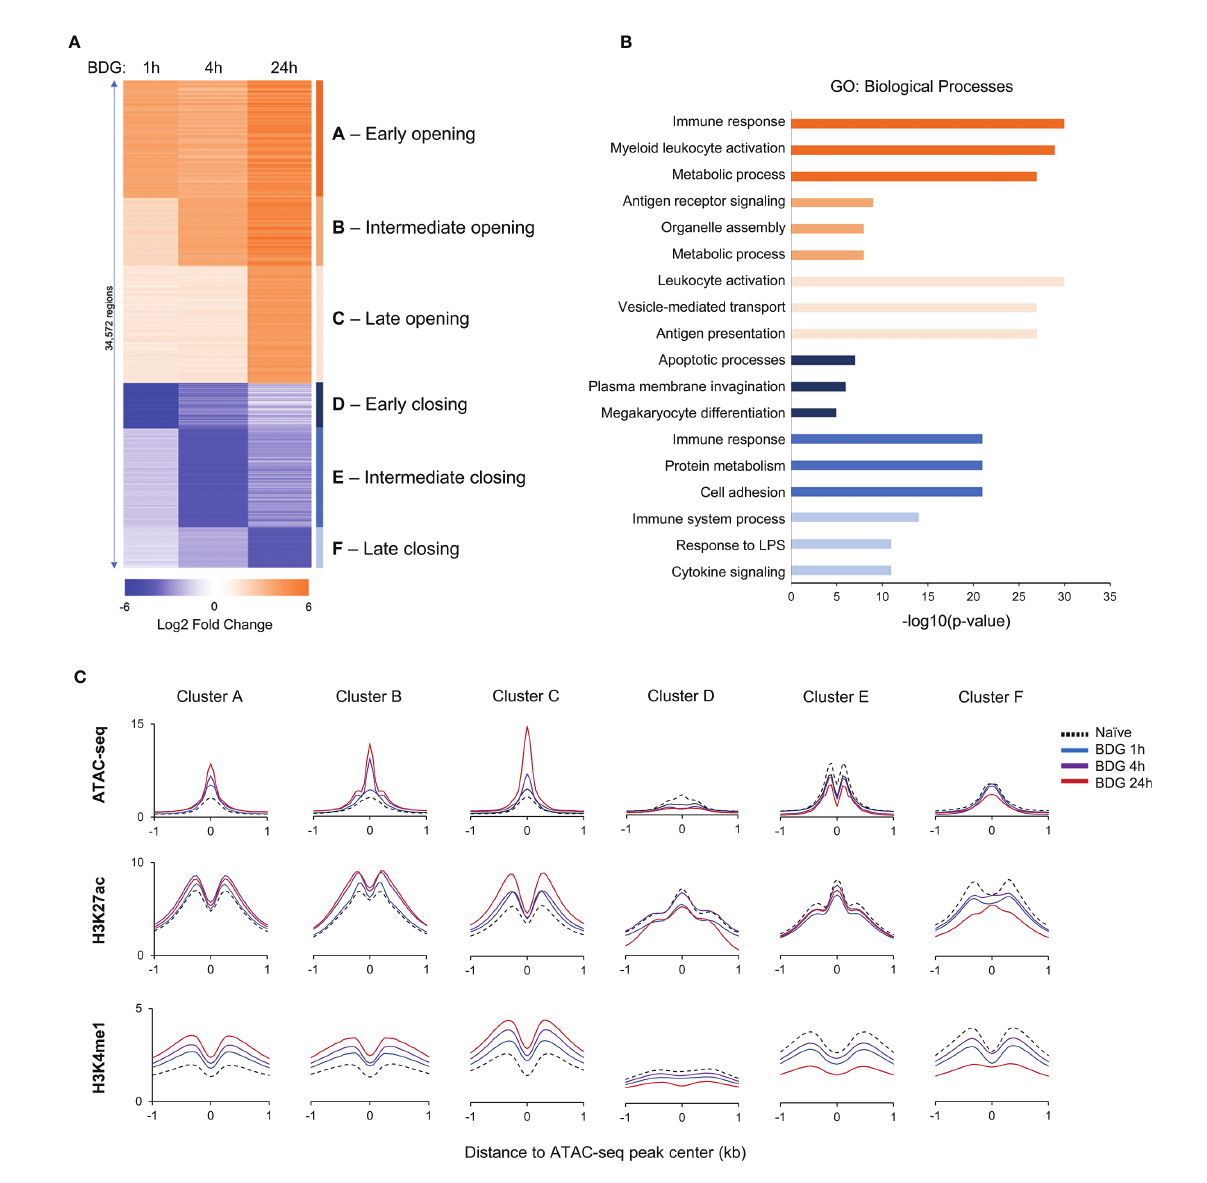
FIGURE 1 | Changes in the epigenetic landscape of monocytes after BDG exposure. (A) Heatmap of differentially accessible regions (DARs) after BDG exposure identi fi ed using ATAC-seq; fold change ≥ |2|. Regions were clustered (groups A-F) based on increase or decrease of chromatin accessibility after 1h, 4h, and 24h of BDG exposure. (B) Gene ontology enrichment analysis for each DAR group de fi ned in panel A; the nearest gene to each DAR with a maximum distance of 500kb were used for the analysis. The top three categories are shown; see Supplementary Table 2B for complete list. (C) Density pro fi les of ATAC-seq, H3K27ac and H3K4me1 ChIP-seq at the DAR clusters. Signal is measured in 50bp bins ( ± 1kb) centered on the ATAC-seq